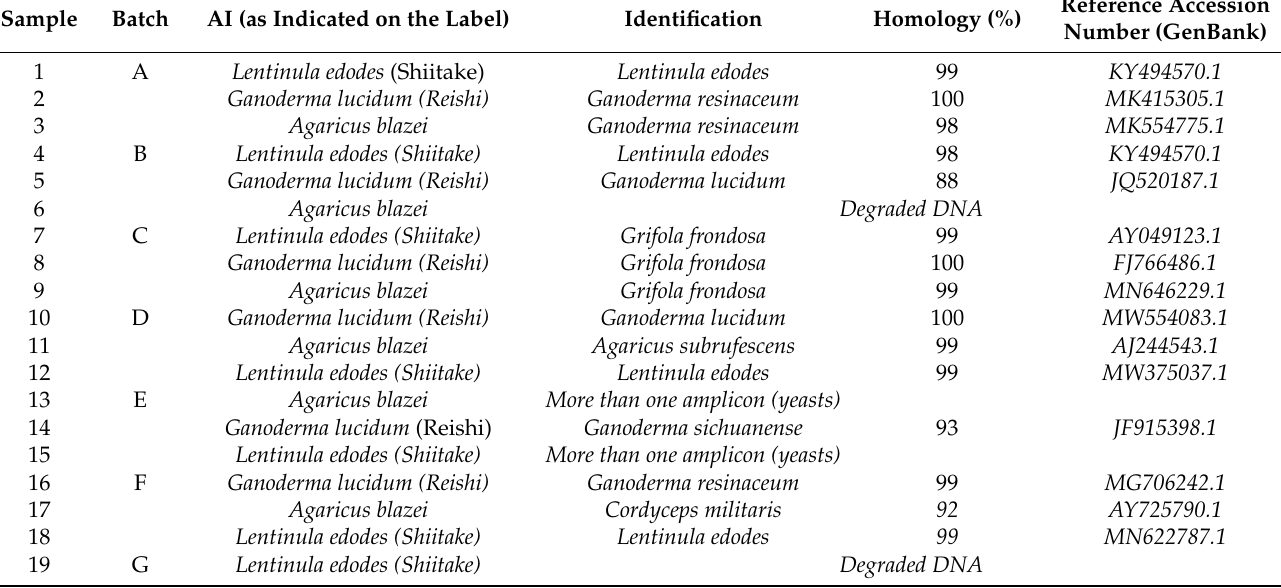
Table 2. Molecular identification, based on the homology of the ITS sequence of the fungal bioac- tive ingredients with sequences deposited in GenBank (https://www.ncbi.nlm.nih.gov/genbank/, accessed on 1 December 2022). Abbreviation: active ingredient,